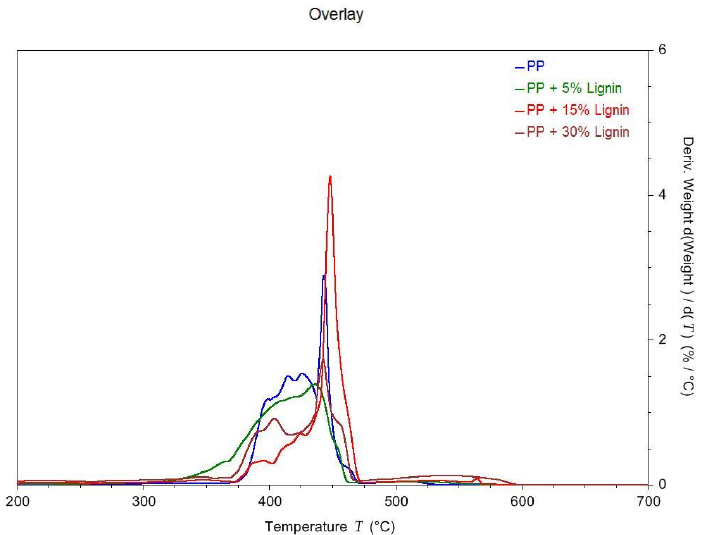
Figure 5. TGA curves for different blends of PP-lignin.